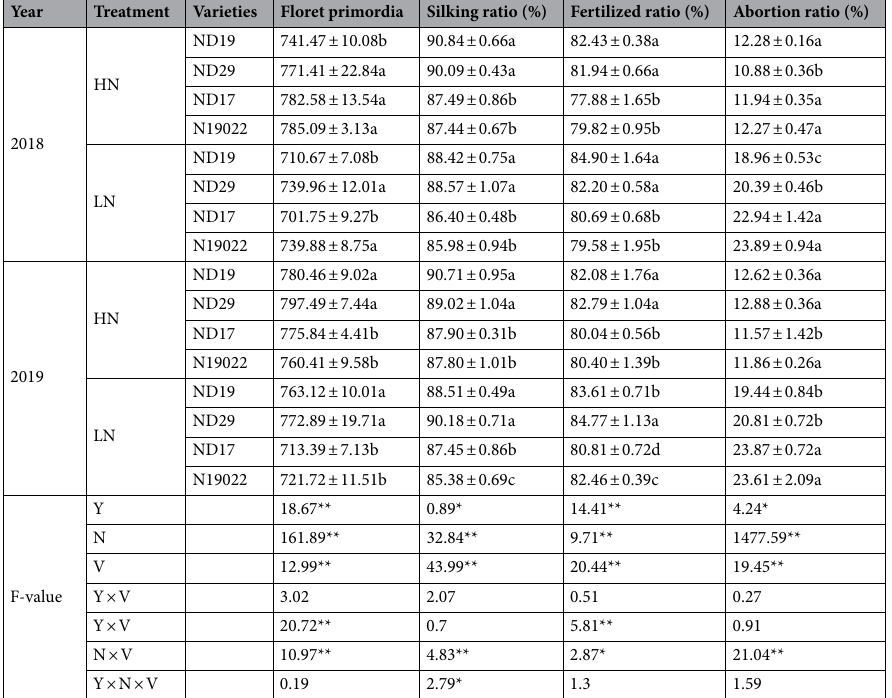
Table 4. Floret growth and development of the four varieties under different nitrogen rate. HN high nitrogen conditions, LN low nitrogen conditions. * and **F values significance at 0.05 and 0.01 probability levels, respectively. Different letters represent significant differences among